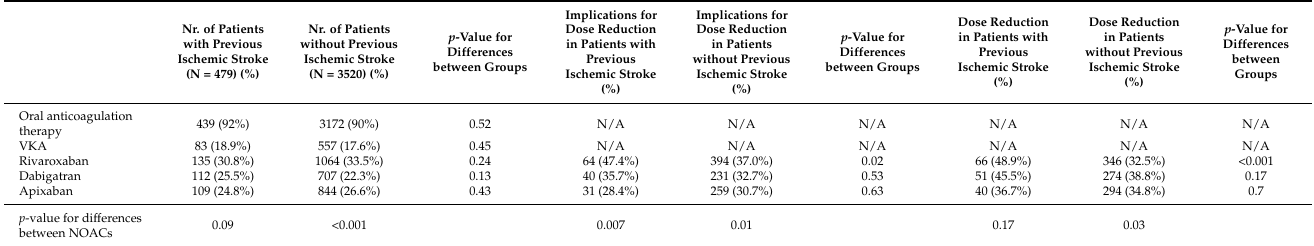
Table 5. Anticoagulation therapy in patients with and without previous ischemic